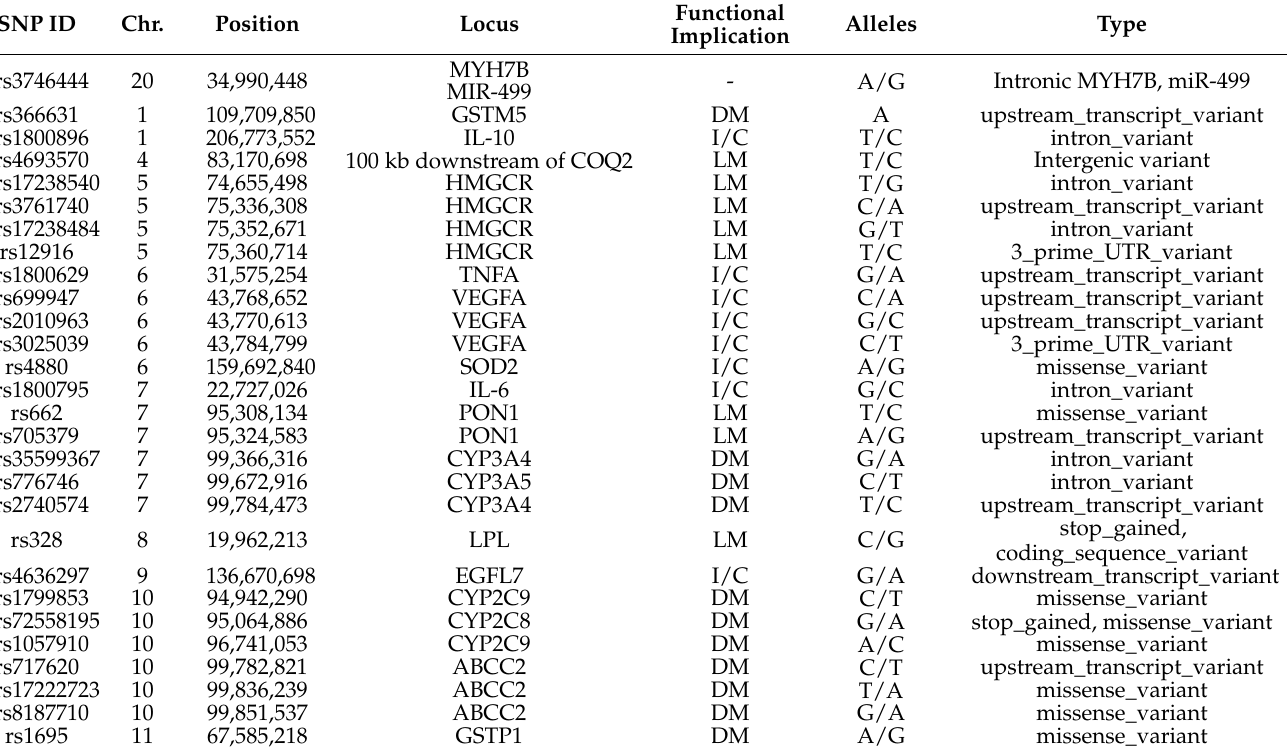
Table 2. Summary of the 34 selected SNPs in 22 genes associated with inflammation and lipid